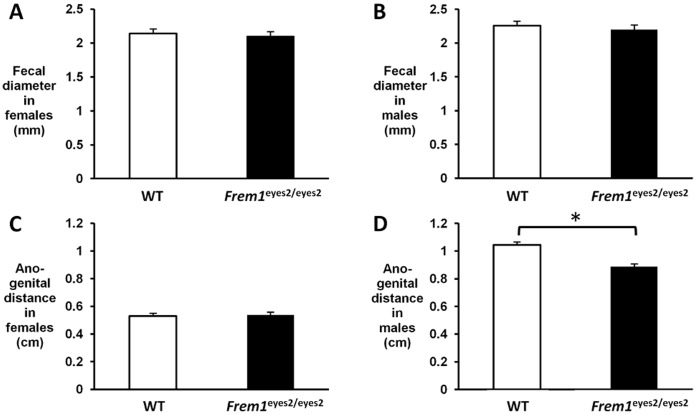
Male Frem1
eyes2/eyes2 mice on a C57BL6 background have decreased anogenital distance.Comparisons of fecal diameter and anogenital distance were made between female and male P28–P30 Frem1
eyes2/eyes2 mice and their sex-matched wild-type littermates on a C57BL6 background. A–B) No significant difference was seen in the fecal diameters of female or male Frem1
eyes2/eyes2 mice compared to their wild-type littermates. C) No significant difference was seen in the anogenital distances of female Frem1
eyes2/eyes2 mice compared to their wild-type littermates. D) The anogenital distances of male Frem1
eyes2/eyes2 mice was significantly smaller than that of their wild-type littermates (p = 0.026) despite having similar weights and lengths. Error bars show standard error of the mean.